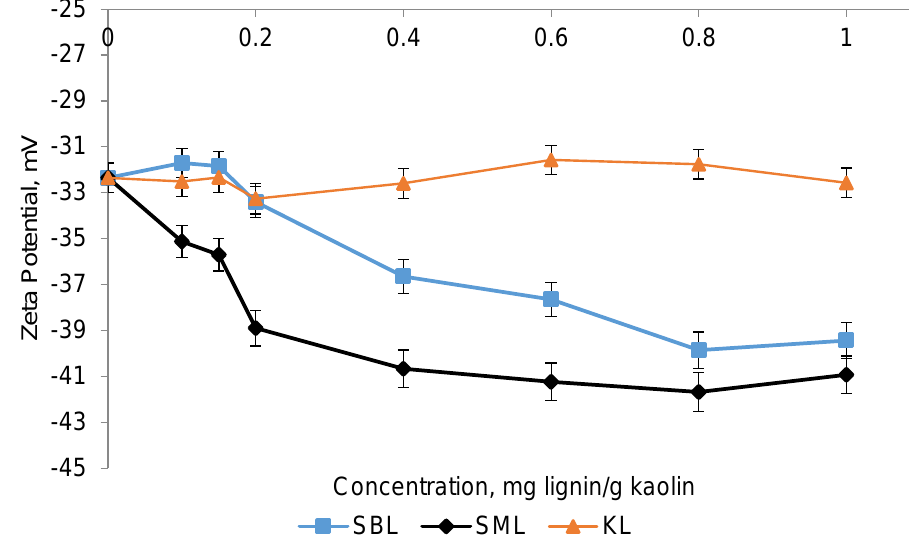
Figure 9. E ff ect of lignin derivative dosage on zeta potential. Figure 9. Effect of lignin derivative dosage on zeta potential. Figure 9. Effect of lignin derivative dosage on zeta potential.